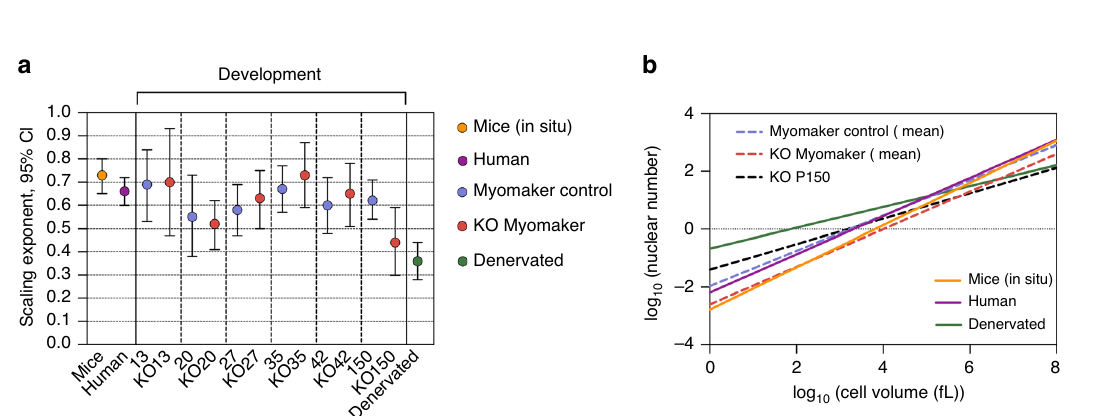
Fig. 6 Nuclear volume is fi xed across development and scale invariant with domain volumes. a Nuclei and fi ber 3D rendered to illustrate the difference in nuclear number and fi ber size between control fi bers (blue nuclei) and Δ 2 w fi bers (red nuclei). Nuclear volume was determined based on fl uorescence from DAPI stained nuclei. Nuclei that were positioned at fi ber ends and only partially visualized were excluded from quanti fi cation. b Mean nuclear volume per fi ber at P27 and P150 between control (blue) and Δ 2 w (red) were statistical non-signi fi cant when tested for differences among group means with a Brown – Forsythe ( F -value of 0.93333 (DF = 3, df = 223), p = 0.4254) and Welch ’ s ANOVA test ( F -value of 1.049 (DF = 3, df = 159), p = 0.3756). c Frequency distribution of nuclear volume plotted independent of fi ber at P27 and P150 ( d ). Mean nuclear volume versus domain volume at P27 ( e ) and P150 ( f ) were statistically tested against a horizontal slope ( b = 0) which gave a F -value of 1.825 and 1.339 at P27 for controls and Δ 2 w fi bers respectively. At P150 the F -value were 2.434 and 0.3173 for the Δ 2 w . All comparisons were statically non-signi fi cant with the corresponding p -value as highlighted in e and f . Source data are provided as a Source Data fi le.